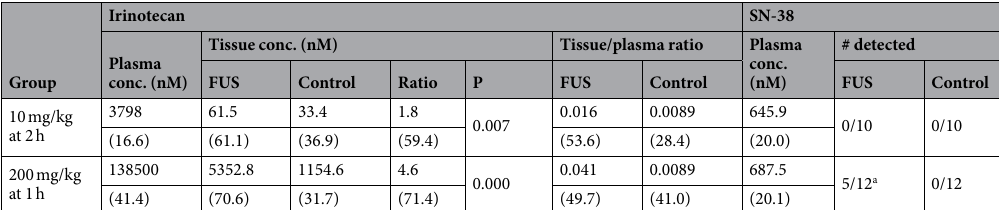
— — — — — — Table 3. Measurements and outcomes for the four sonicated volumes. a No 24 h MRI in one animal. b No 7d MRI after session 3.